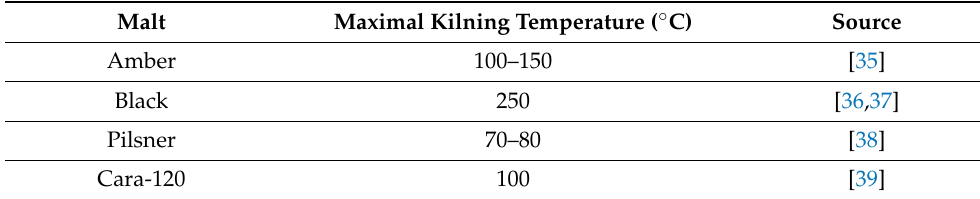
Table 2. Kilning temperatures for analyzed